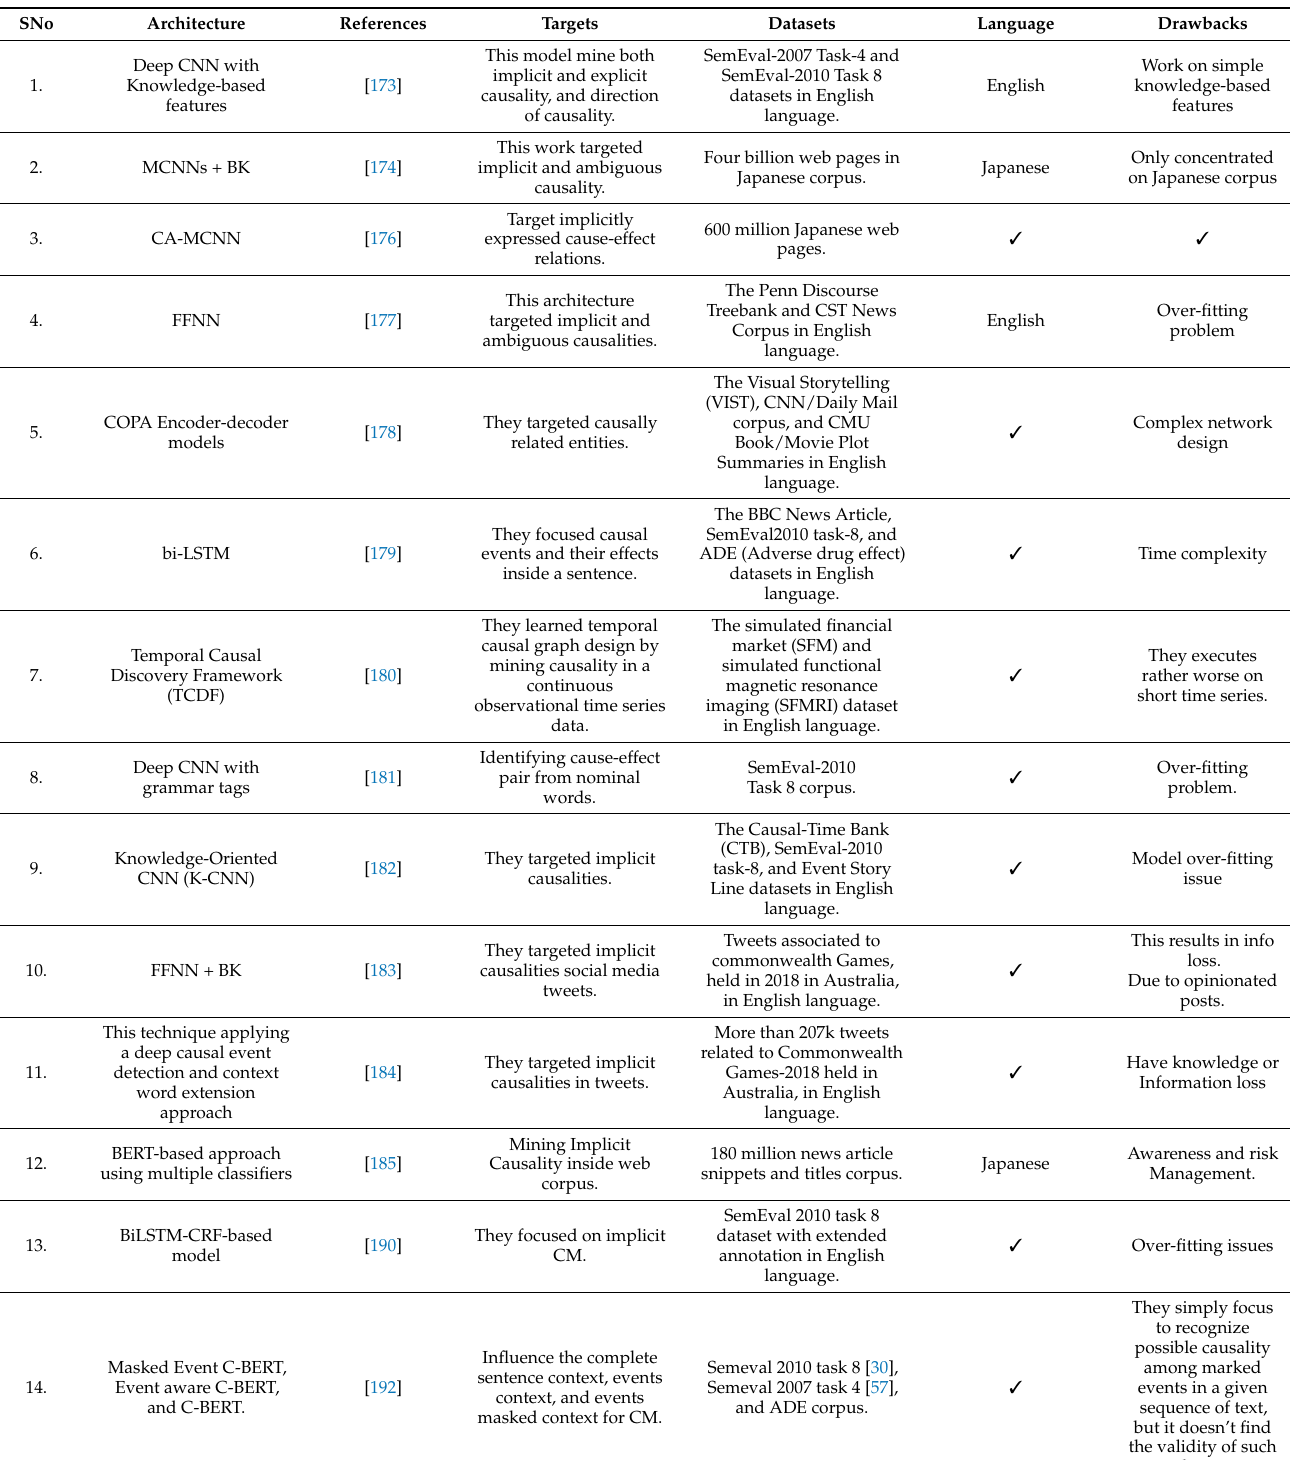
Table 5. Summary of deep learning networks for